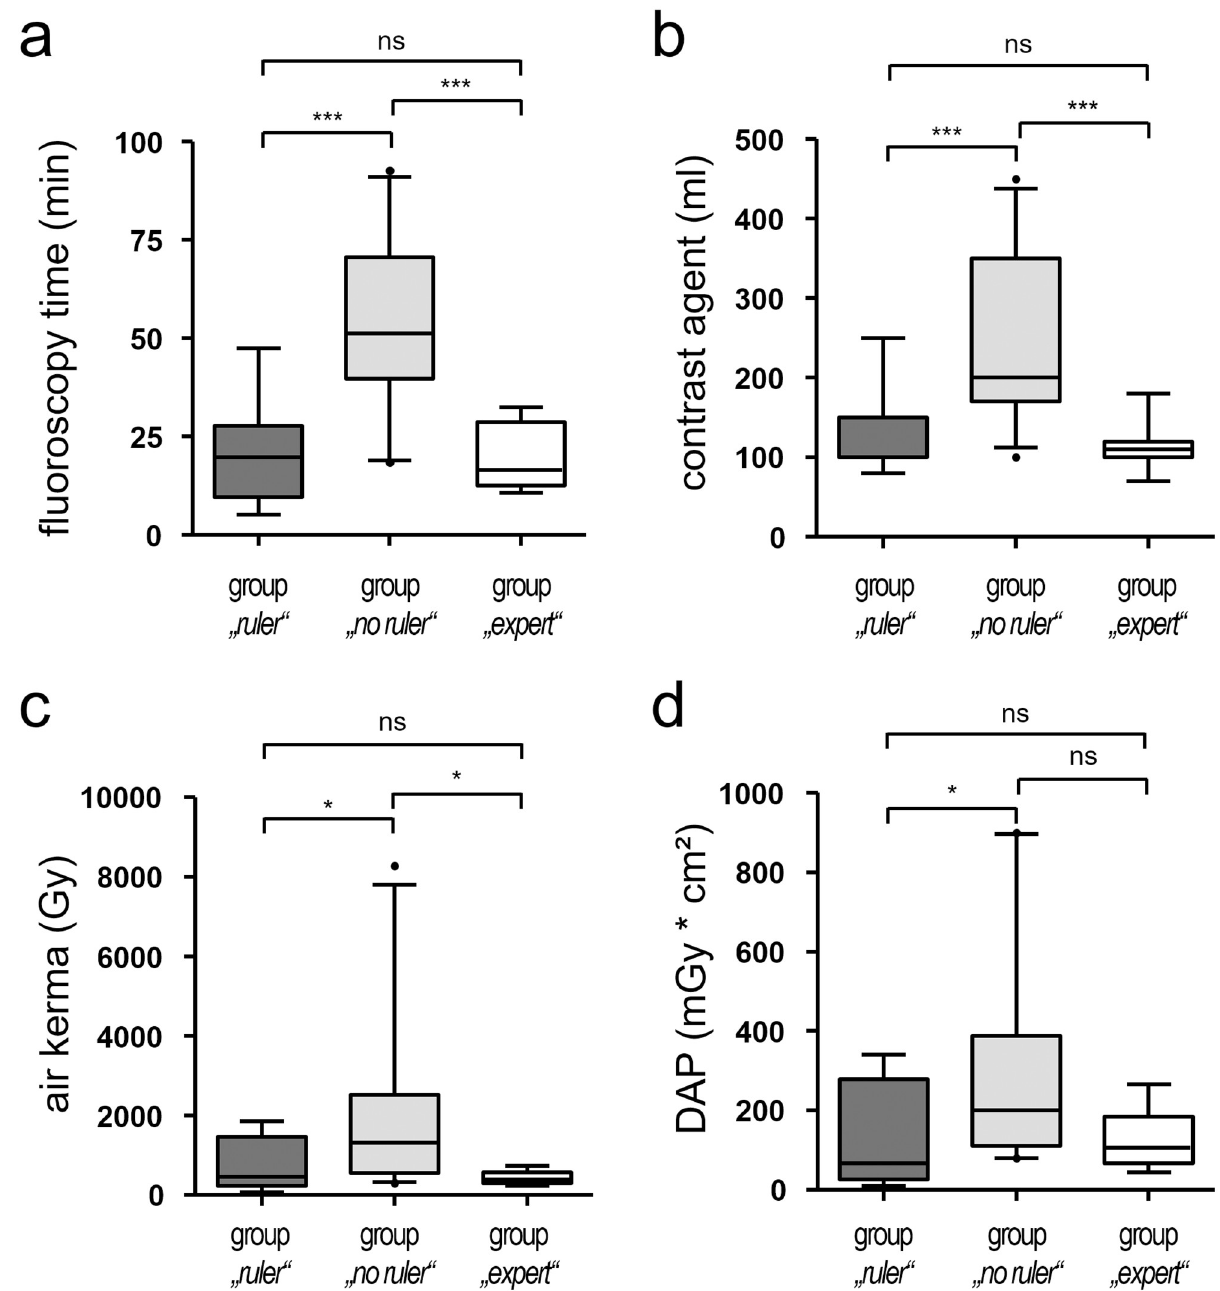
Fig 3. Comparison of fluoroscopy time (a), contrast volume (b), air kerma (AK) (c), and dose area product (DAP) (d) during adrenal vein sampling. Procedures were performed either by one non-expert radiologist using a radiopaque ruler (group “ruler” ), by three non-expert radiologists without ruler (group “no ruler” ), or by one expert radiologist without ruler (group “expert” ) to determine the distance of right renal vein (RRV) to right adrenal vein (RAV). Box plot analyses illustrate significantly lower fluoroscopy time (a) , volume of contrast agent (b) , AK (c) , and DAP (d) in group “ruler” compared to group “no ruler” , without being statistically significantly different from group “expert” . Boxes range from first to third quartile, horizontal lines indicate median, and whiskers indicate 5 th -95 th percentiles. Ns: not significant, � : p < 0.05, ��� : p < 0.001.